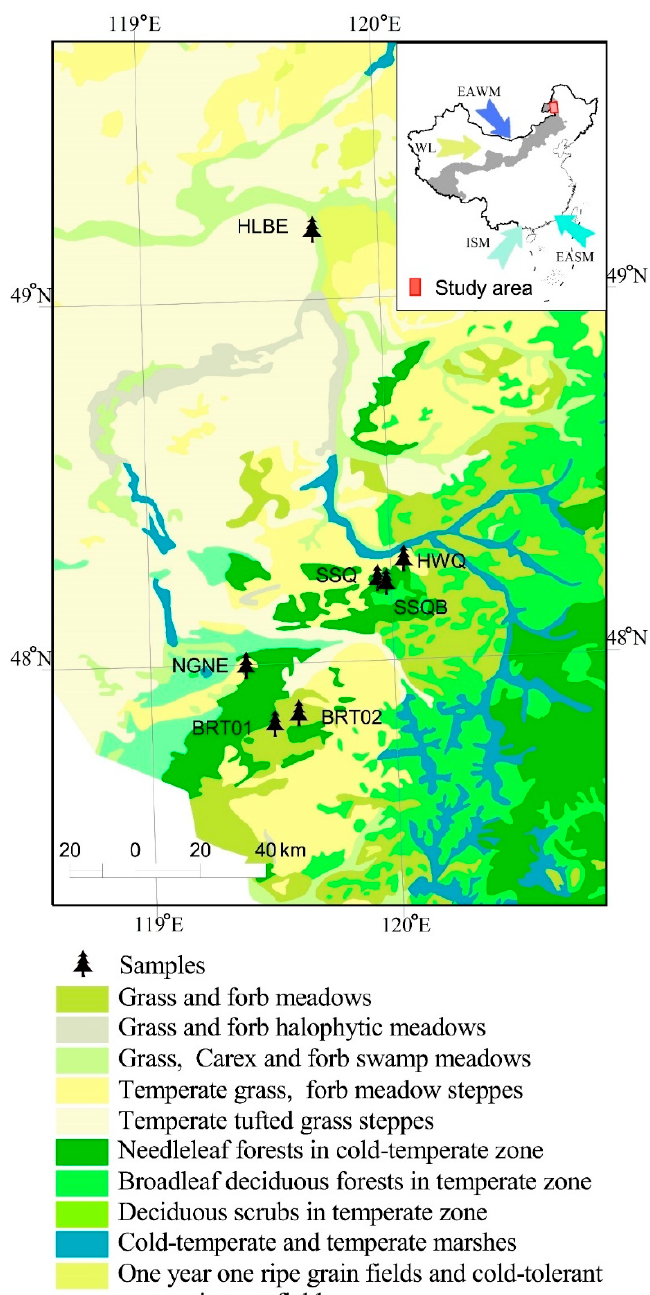
Figure 1. The locations of the sampling sites in the Da Hinggan Mountains in this paper. The grey area in the small picture in the upper right represents the northern margin of the Asian Summer Monsoon. EASM denotes the pathway of the East Asian Summer Monsoon, EAWM denotes the pathway of the East Asian Winter Monsoon, ISM represents the pathway of the Indian Summer Monsoon and WL represents the